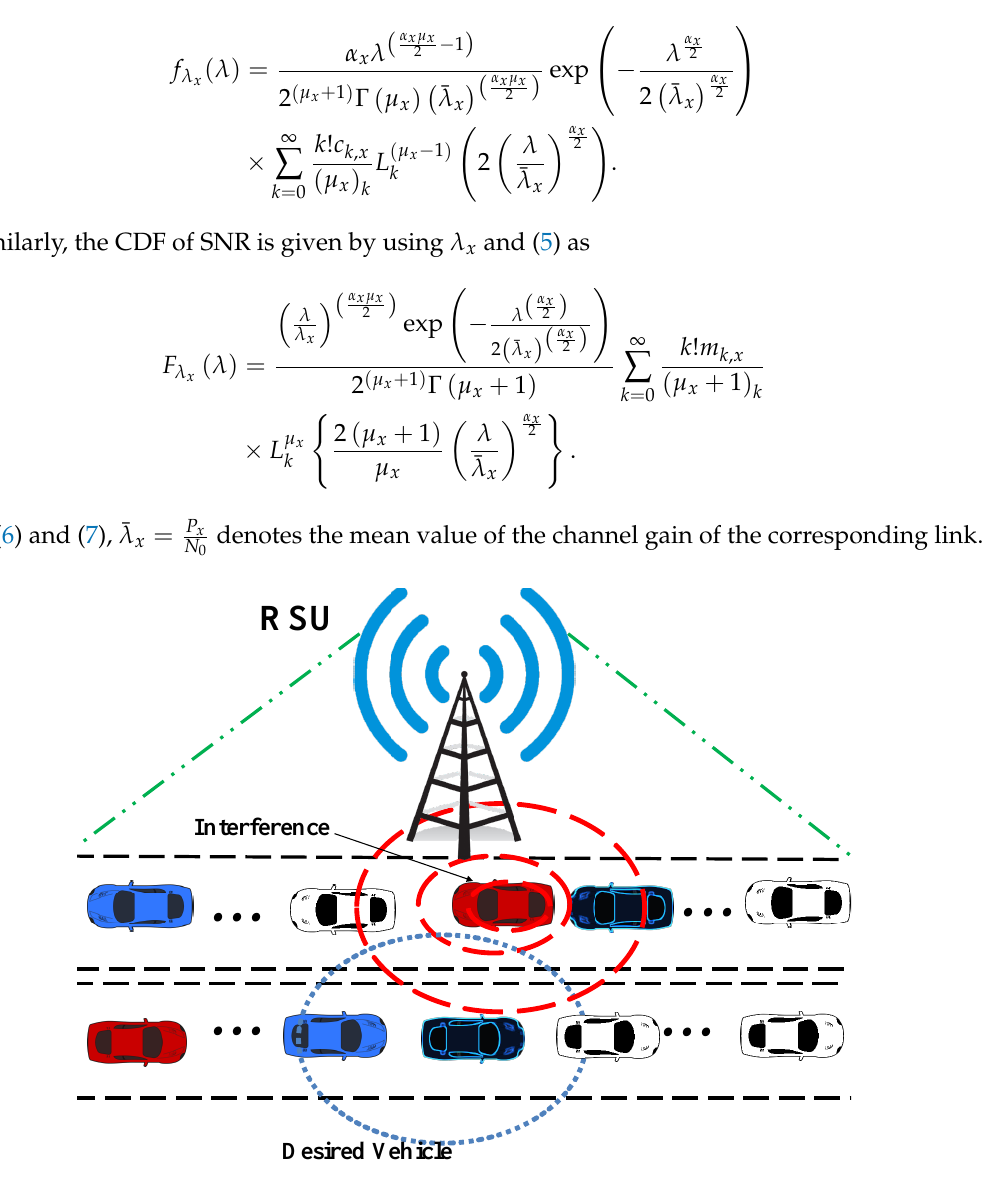
Figure 1. System model for V2V